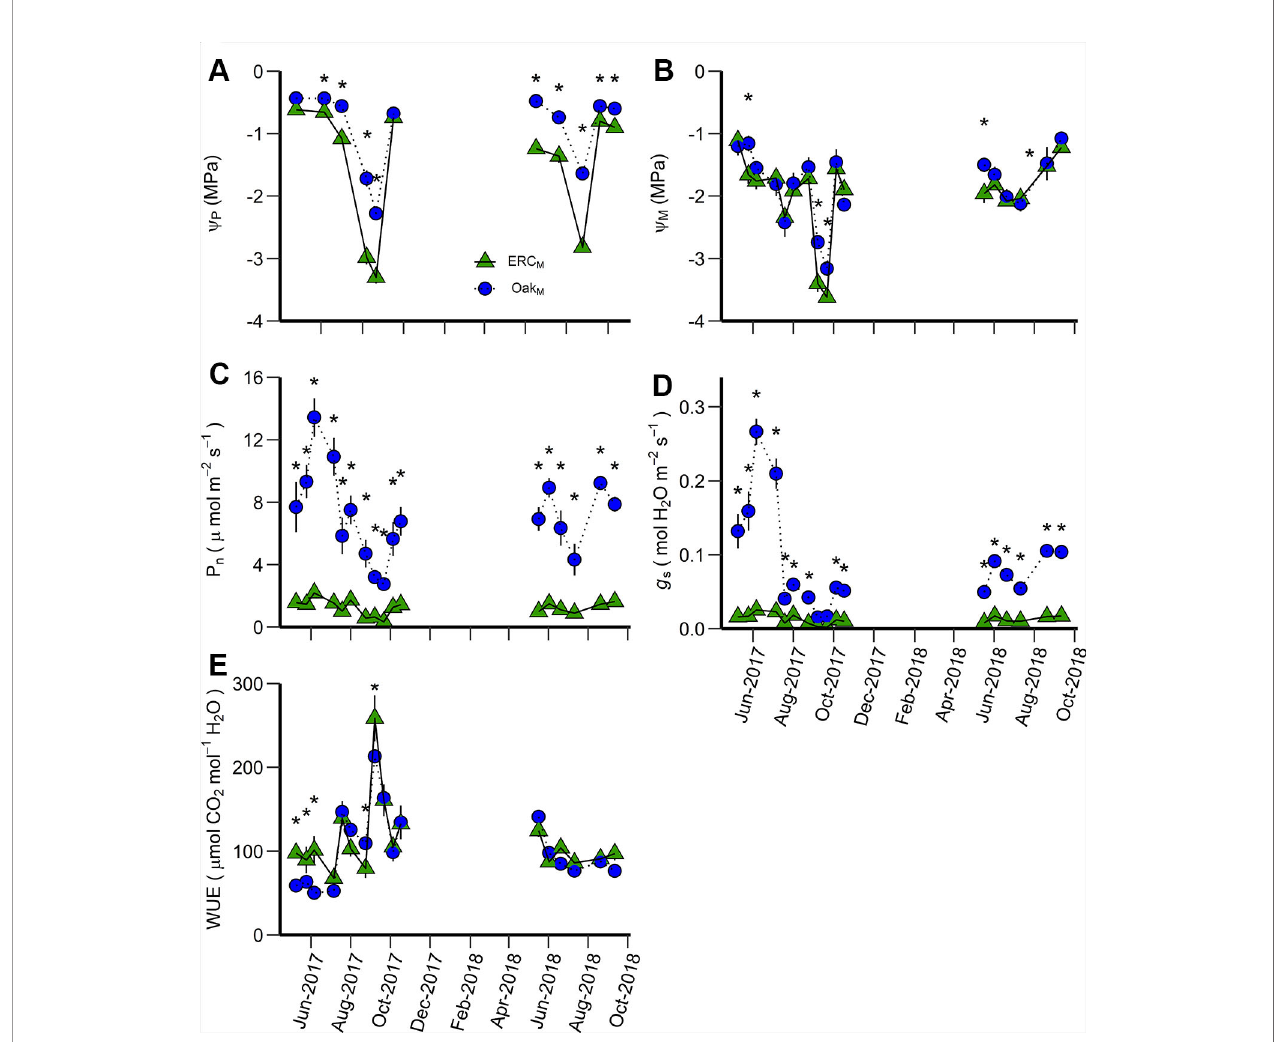
FIGURE 5 | Predawn water potential ( Y P ) (A) , midday water potential ( Y M ) (B) , net photosynthetic rate (P n ) (C) , stomatal conductance (g s ) (D) , and water use ef fi ciency (WUE) (E) for ERC M vs. Oak M . ERC M and Oak M are eastern redcedar and post oak trees growing in a mixed-species stand. An asterisk (*) indicates signi fi cant differences on speci fi c dates (p < 0.05). Vertical bars represent standard errors of measurements at each date (not shown when smaller than the symbol